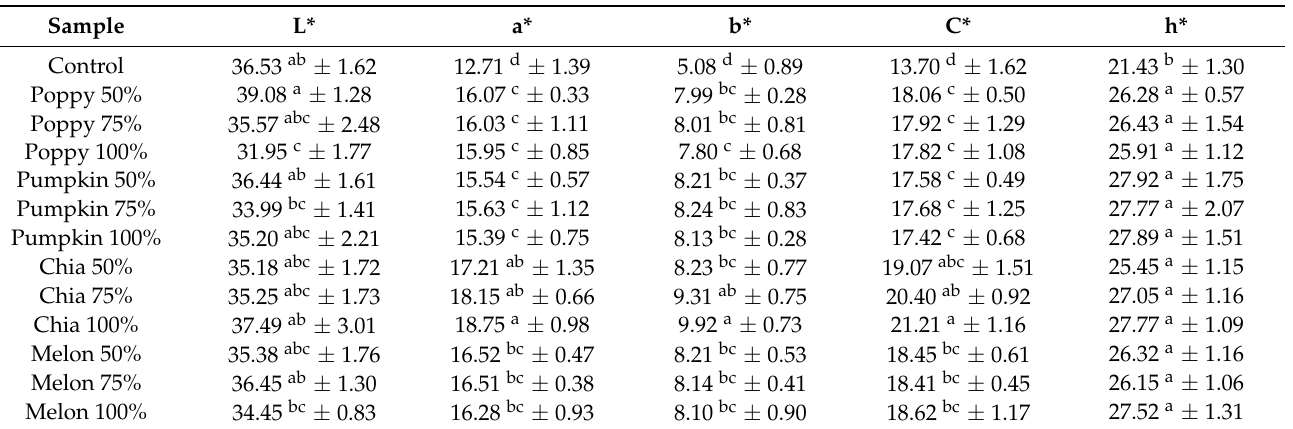
Table 2. Results obtained for the color parameters of the fuet samples prepared with different emulsified seed